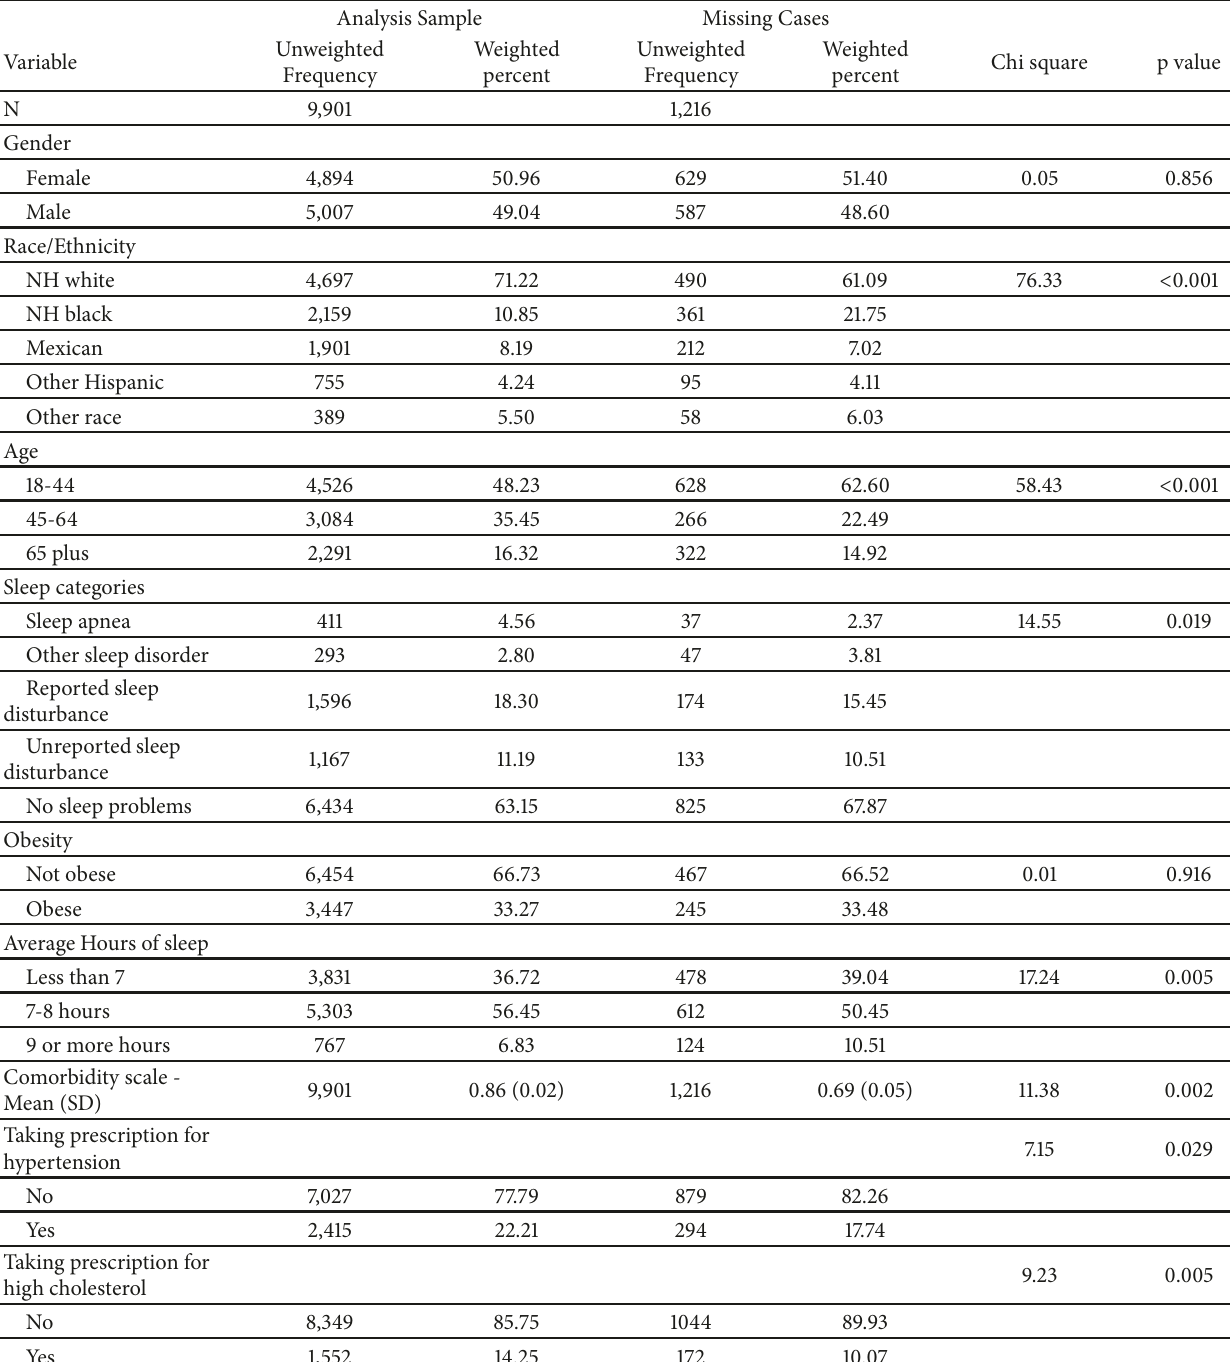
Table 5: Frequencies and weighted percentage comparison between analysis sample and missing